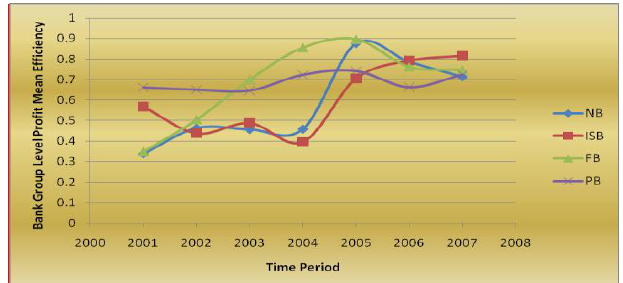
Figure 2: Bank group level profit mean efficiency over time